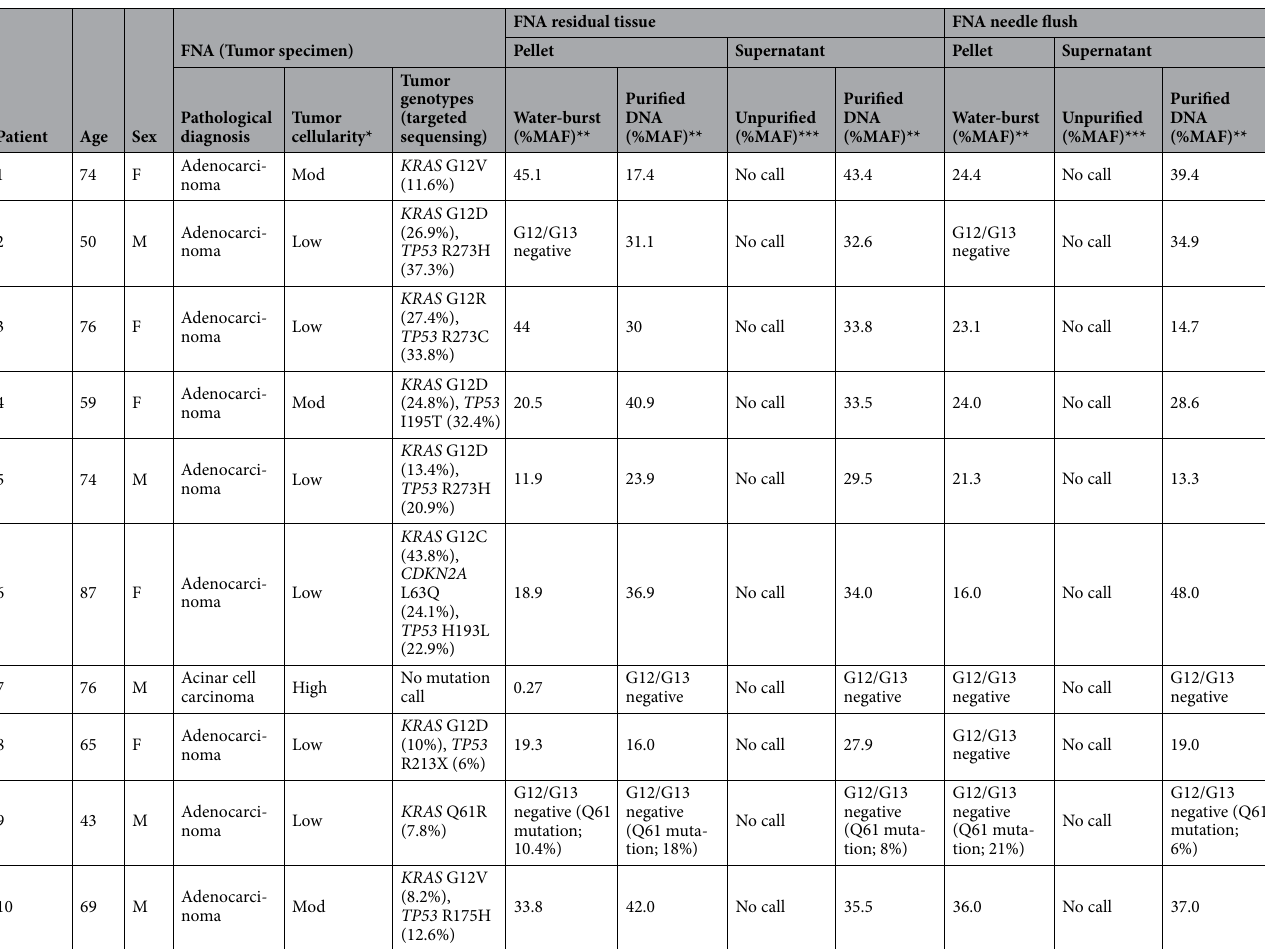
Table 2. Mutation analysis using residual tissues in FNA needles. MAF mutant allele frequency. *Tumor cellularity; High, > 30%; Moderate (Mod), 10–30%; Low, < 10%. **G12/G13 negative; KRAS G12/G13